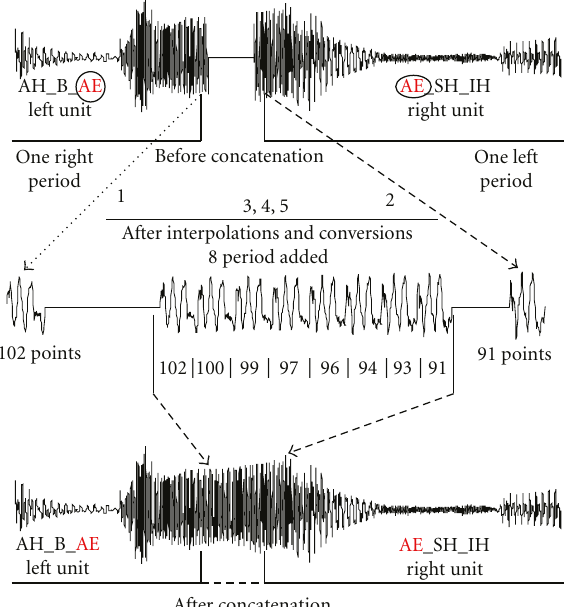
Figure 4: The proposed concatenating algorithm used to link two units: /AH B AE/ and /AE SH IH/.